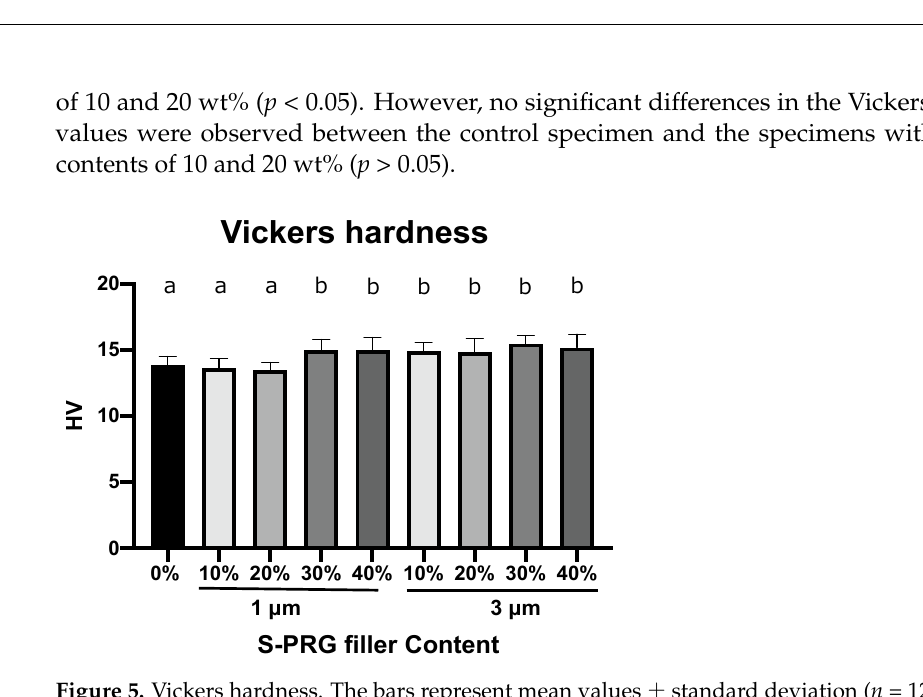
Figure 5. Vickers hardness. The bars represent mean values ± standard deviation ( n = 12). Different letters indicate statistical significance ( p < 0.05). Table 2. Vickers Hardness values of the specimens (control, S-PRG-1, and S-PRG-3). S-PRG Filler Content (wt%)